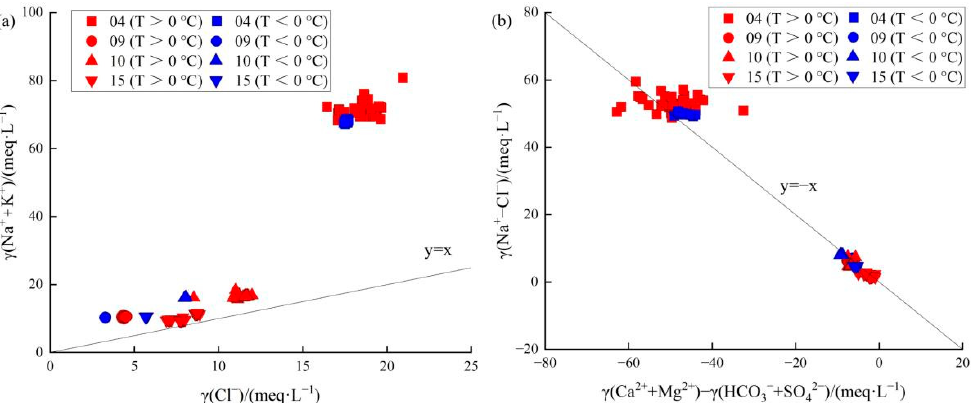
Figure 9. Ion concentration relationships for samples from the four springs. ( a ) γ (Na + + K + )/ γ (Cl − ) and ( b ) γ (Na + − Cl − )/[ γ (Ca 2+ + Mg 2+ ) − γ (HCO 3 − +SO 42 − )].